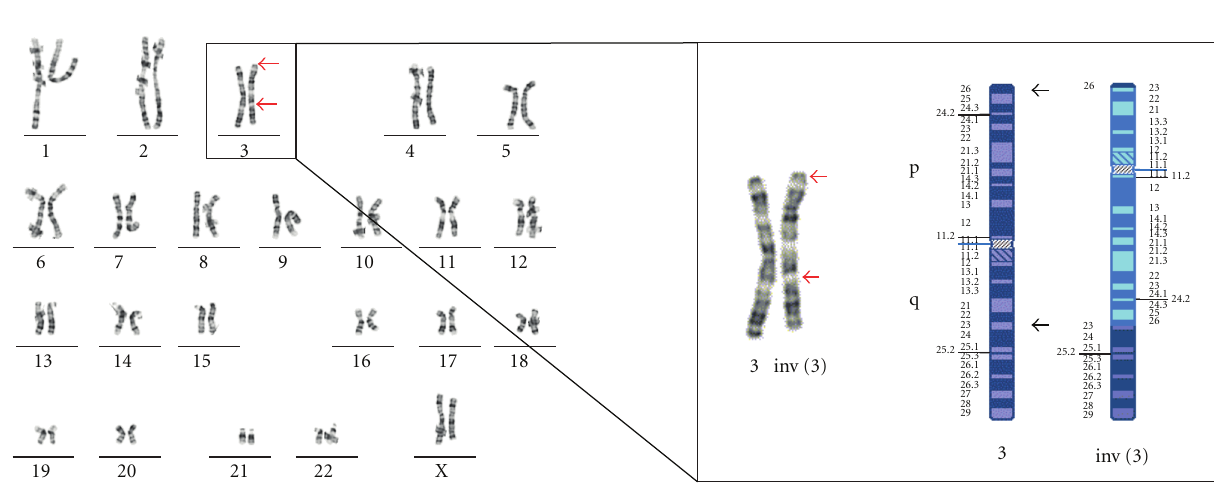
Figure 3: Karyotype and chromosome 3 ideogram of maternal chromosomes. Panel A shows the karyotype of the mother 46,XX,inv(3)(p26.3q23). Panel B shows the normal and structurally rearranged chromosomes 3, together with an associated